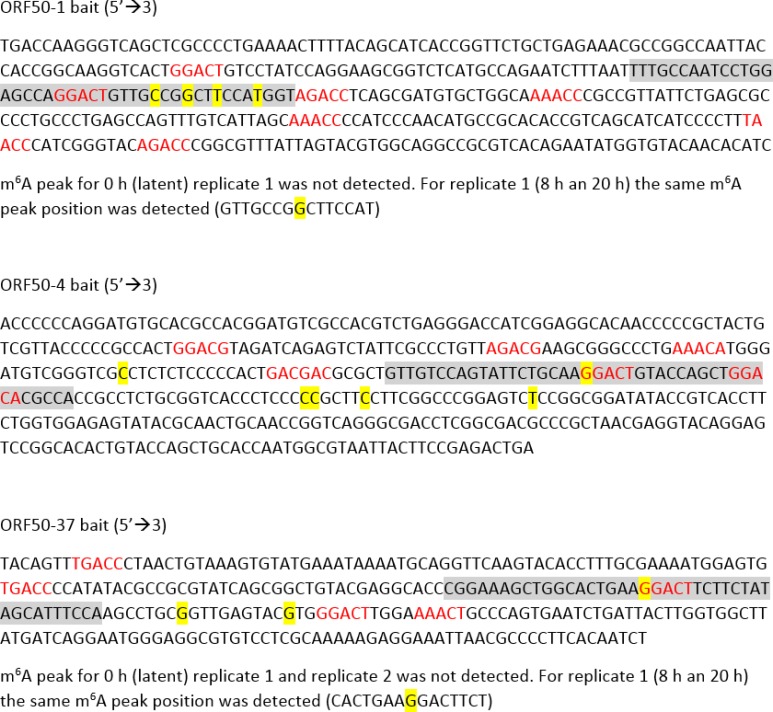
m6A peak positions from all m6A-seq biological replicates studied.m6A peak positions are highlighted in yellow for all biological replicates and time-points studied (0 hr, 8 hr and 20 hr post-reactivation). m6A-methylation motifs are highlighted in red and sequences selected for RNA affinity are shaded in grey. Note that the GGACT motif is centred in the middle of each RNA affinity bait.